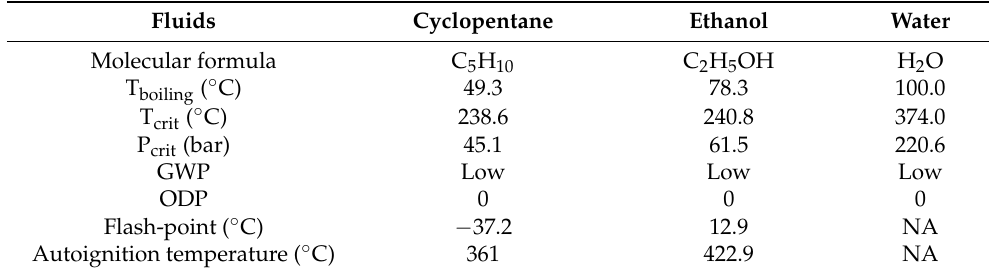
Table 8. Properties of selected working fluids compared with water.